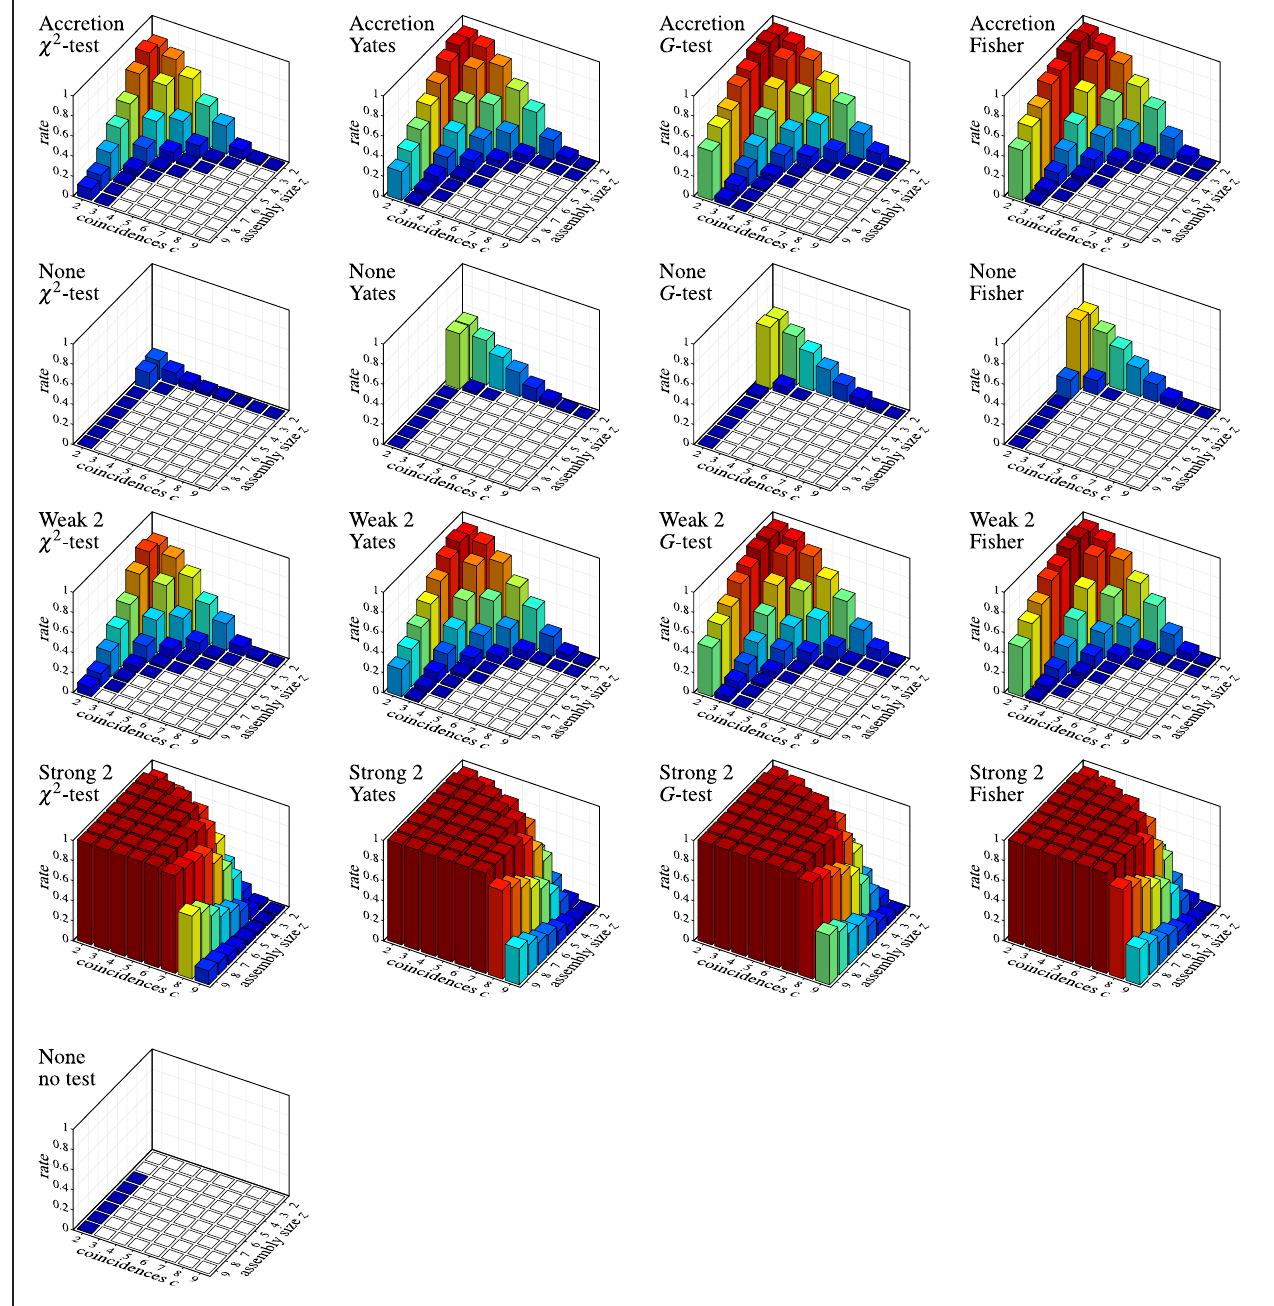
if it is not contained in any of the maximal synchronous groups produced by the used detection method. Pure FIM (see diagram on the left) necessarily always detects all injected patterns perfectly, unless they are reduced to less than two coincidences by “clipping” caused by the time